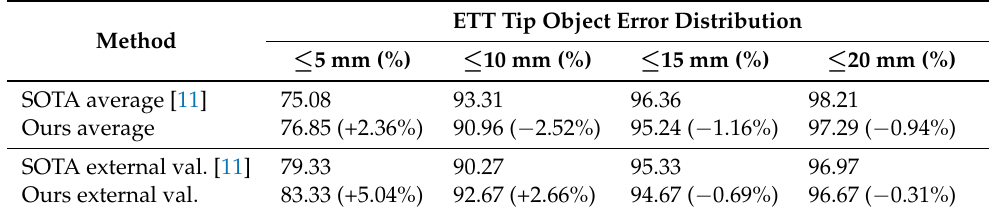
Table 12. The comparison results of error distribution on the ETT tip.